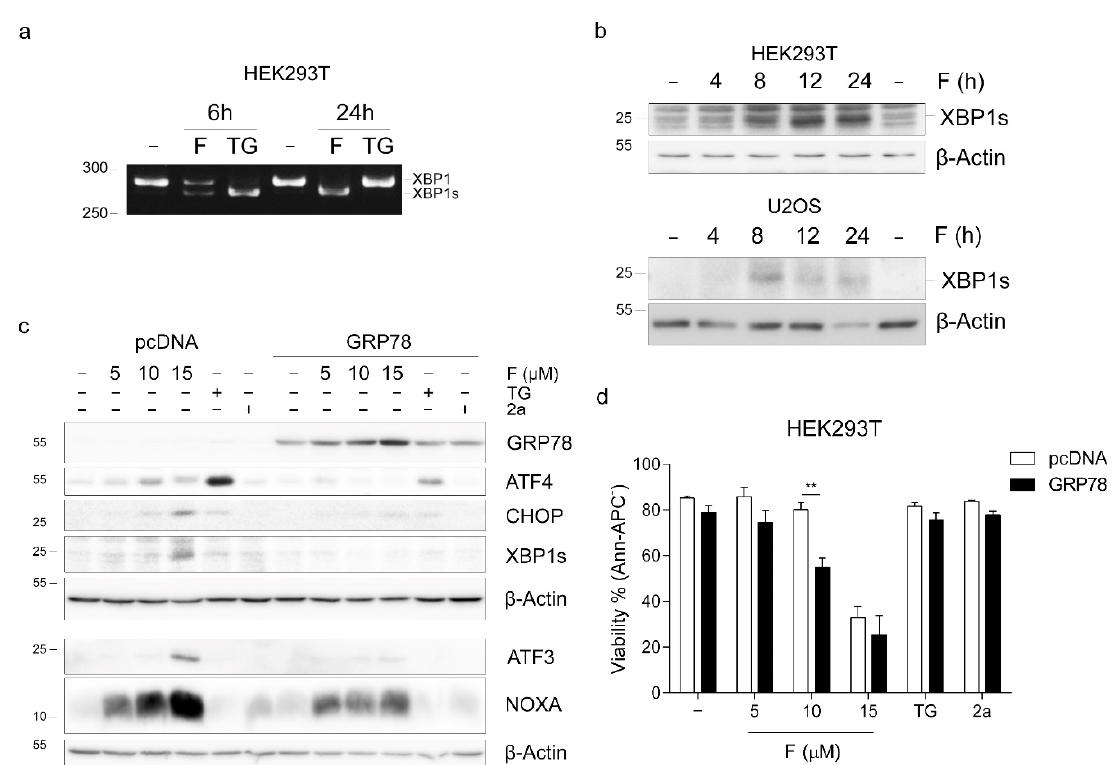
Figure 3. Fluorizoline induces ER stress in HEK293T and U2OS cells. ( a , b ) HEK293T and U2OS cells were treated with ( a ) 15 µ M fluorizoline (F) or 20 µ M thapsigargin (TG) for the indicated time or ( b ) 15 and 20 µ M fluorizoline, respectively, for the indicated time. ( c , d ) HEK293T cells were transfected with empty pcDNA or with GRP78 for 48 h and then treated with the indicated doses of fluorizoline, 15 µ M compound 2a as a negative control or 20 µ M thapsigargin (TG) for 24 h. ( a ) Unspliced ( XBP1 ) and spliced XBP1 ( XBP1 s) mRNA were detected by PCR. This is a representative image of two independent experiments. ( b , c ) Protein levels were analyzed by Western blot. β -actin was used as a loading control. Images proceeding from different gels are separated with white space. These are representative images of at least three independent experiments. ( d ) Viability was measured by flow cytometry, and it is expressed as the mean ± SEM of the percentage of non-apoptotic cells (annexin V-negative). ** p < 0.01. ISRIB vs. -; GRP78 vs. pcDNA ( n = 3).